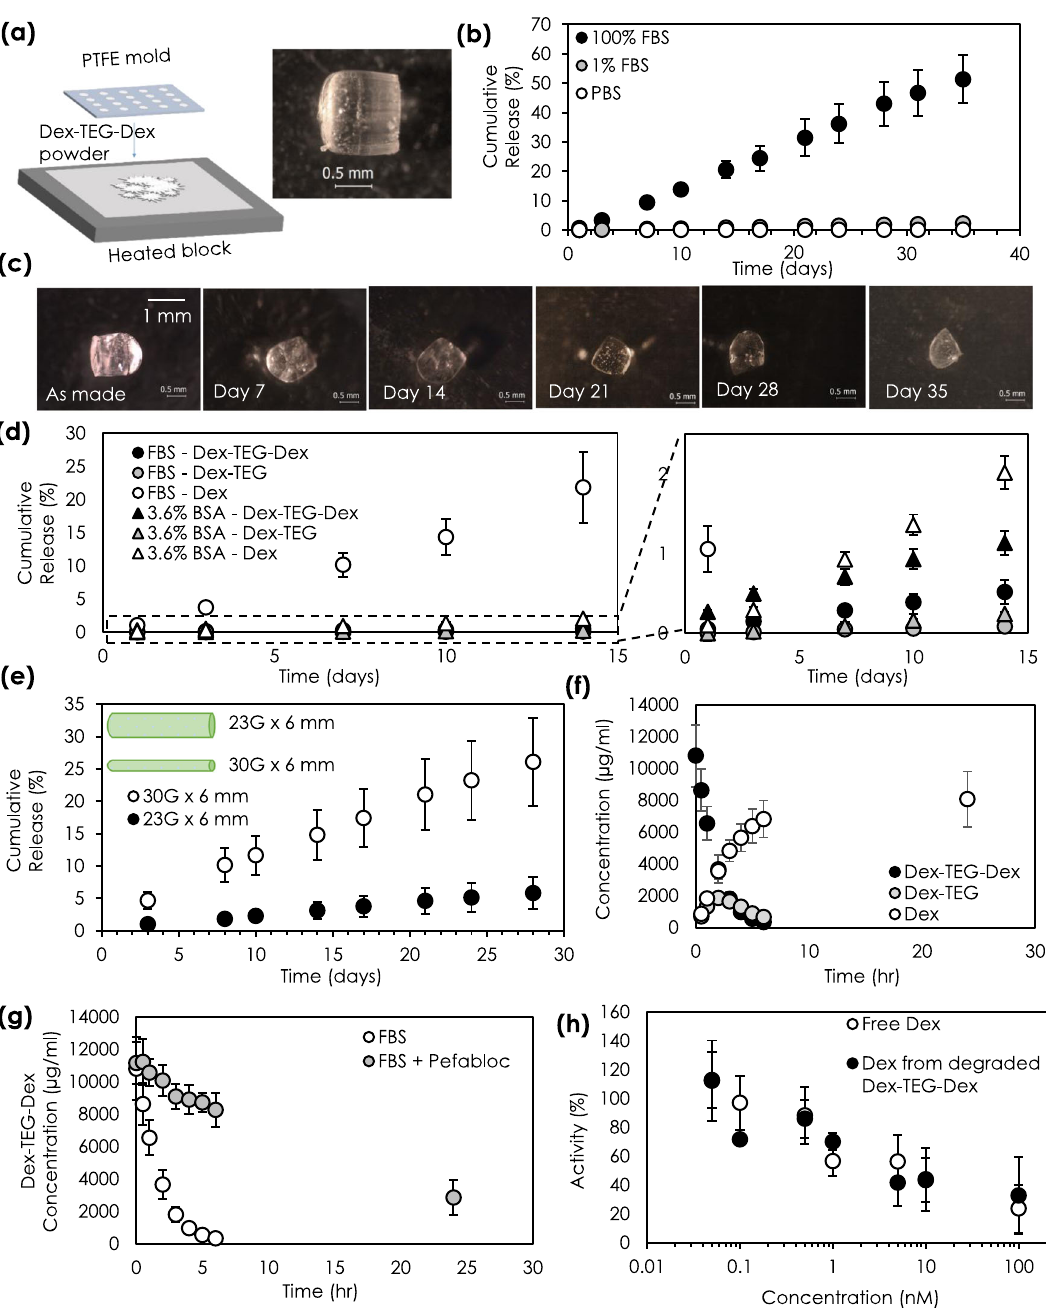
Fig. 4 Characterization of the drug release behavior of a corticosteroid dimer implant. a Method of thermally processing crystalline dimers into pellets for in vitro release testing. b Release kinetics of dexamethasone from thermally processed pellets in 100% fetal bovine serum (FBS), 1% FBS in phosphate- buffered saline (PBS) (pH 7.4), and PBS (pH 7.4) (2 ml). Total drug loading was 1.17 ± 0.24 mg, 1.13 ± 0.17 mg, and 0.85 ± 0.03 mg dexamethasone (Dex) for 100% FBS, 1% FBS, and PBS release conditions, respectively. N = 3 samples. c Light micrographs demonstrating the surface erosion phenomenon, where pellets in FBS decrease in size over time as dimer is solubilized from the surface and degraded into free drug, resulting in surface erosion-based release kinetics. d Comparison of free dexamethasone release pro fi les in equivalent protein environments with differing hydrolytic enzyme activity (FBS (high) and 3.6% bovine serum albumin (BSA) (low)) in PBS pH 7.4 (2 ml). Total drug loading was 1.28 ± 0.19 mg Dex. N = 3 samples for FBS and N = 6 samples for BSA. e Demonstration of release rate and its dependence on sample diameter. Total drug loading of 63 ± 16 µ g for 30 G × 6 mm implants and 348 ± 141 µ g for 23 G x 6 mm implants. N = 6 samples for 23 G and N = 5 samples for 30 G implants. Due to the surface erosion mechanism of release, material diameter is directly correlated to duration of release. Degradation kinetics of solubilized dimer in f fetal bovine serum (N = 3 samples) showing full conversion to free drug ( g ) with and without the presence of a protease inhibitor (Pefabloc, 1 mg/ml) ( N = 3 samples). h Inhibition of LPS-induced stimulation of PGE2 production by primary human monocytes in the presence of free dexamethasone and dexamethasone released from Dex-TEG-Dex (N = 3). In all panels, data represent the mean ± standard